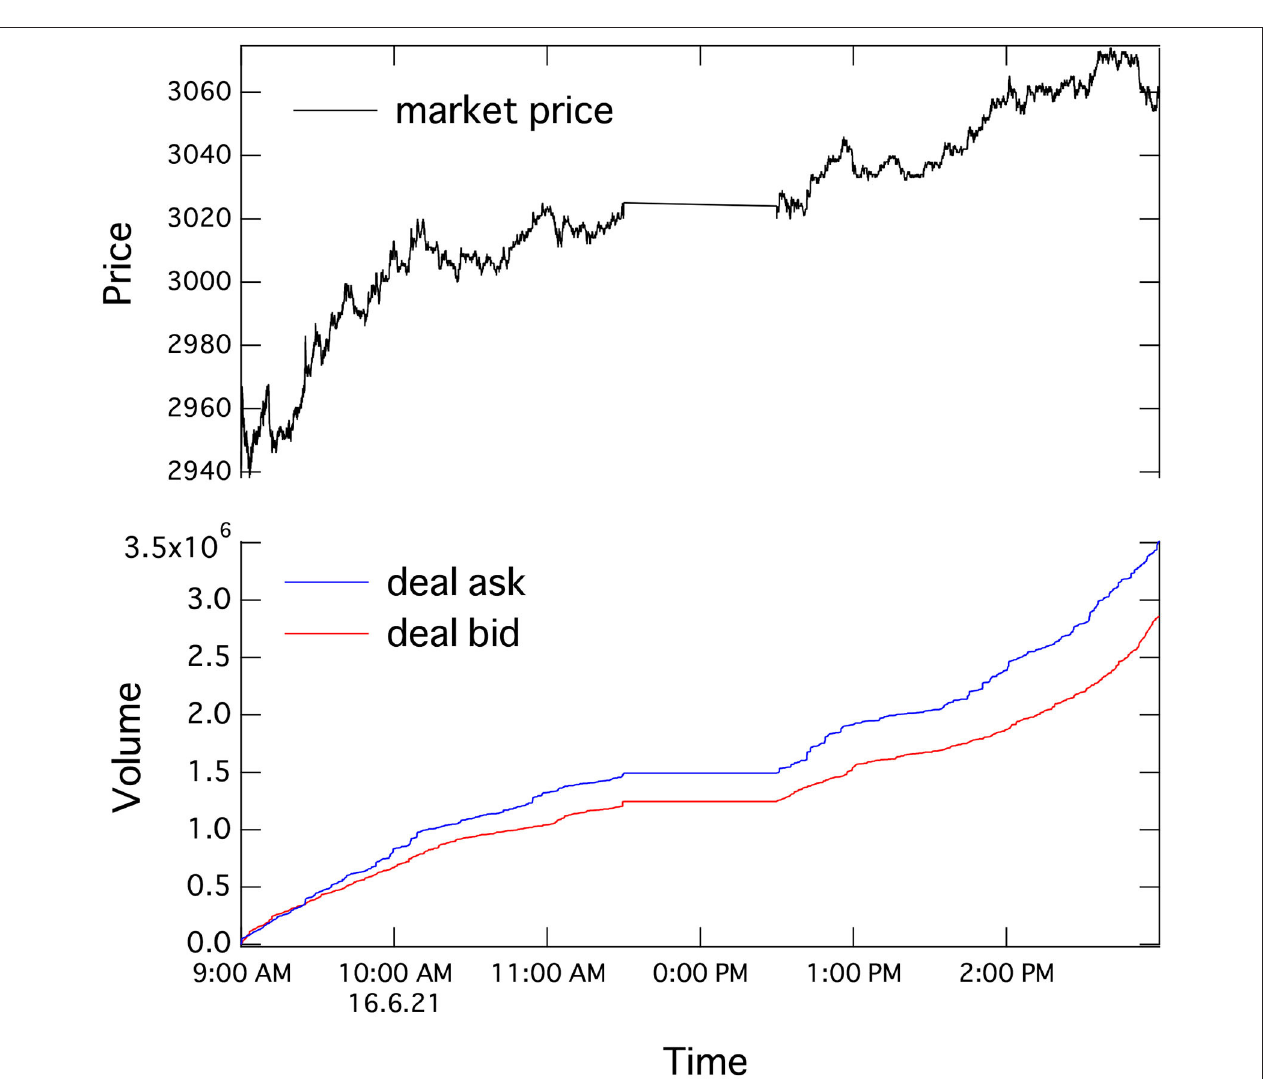
FIGURE 1 | Time series of market price and cumulative transaction volume of Sony (stock code: 6758) from 1 second past 9 a.m. to 1 second before 3 p.m. on June 21,